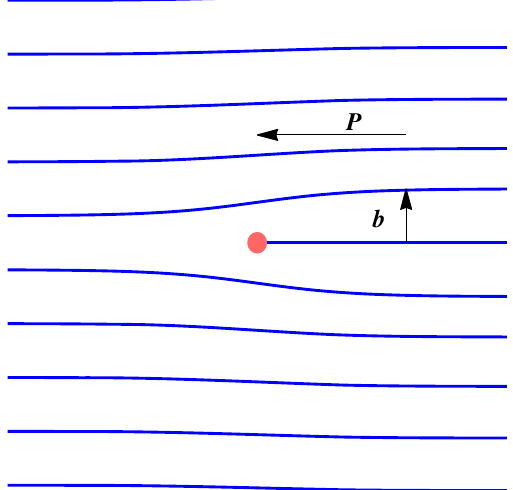
FIG. 5. An edge dislocation in 2D with the Burgers vector b . In the presence of a polarization P ⊥ b , charge gets accumulated at the core of the dislocation, shown by the red